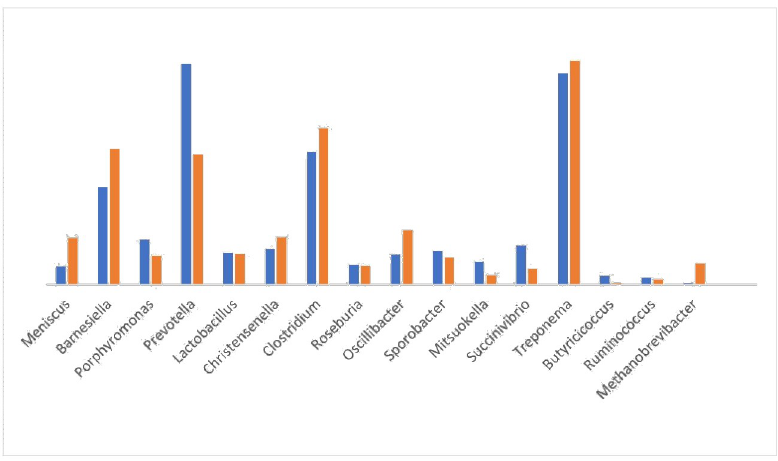
Fig 6. Bacterial taxonomic compositions of genus